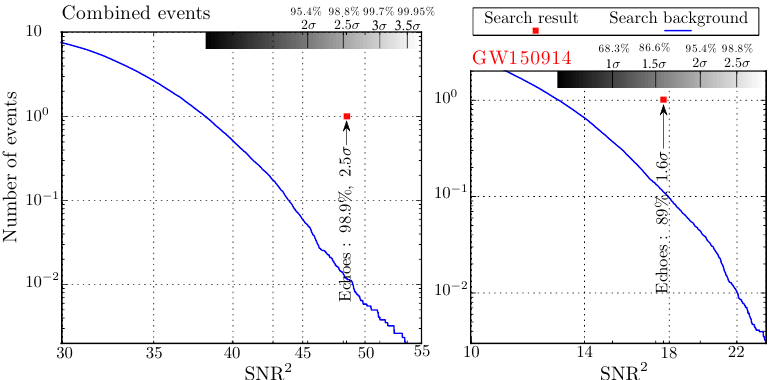
Figure 18. Same as Figure 17, but over an extended range of x = t echo − t merger predicted value of 1 0.01 < x < 1 + 0.01 within gray rectangle have false detection probability of 0.11 − (0.011) and significance of 1.6 σ (2.5 σ ), for GW150914 (combined events) [18] (See also [27]).